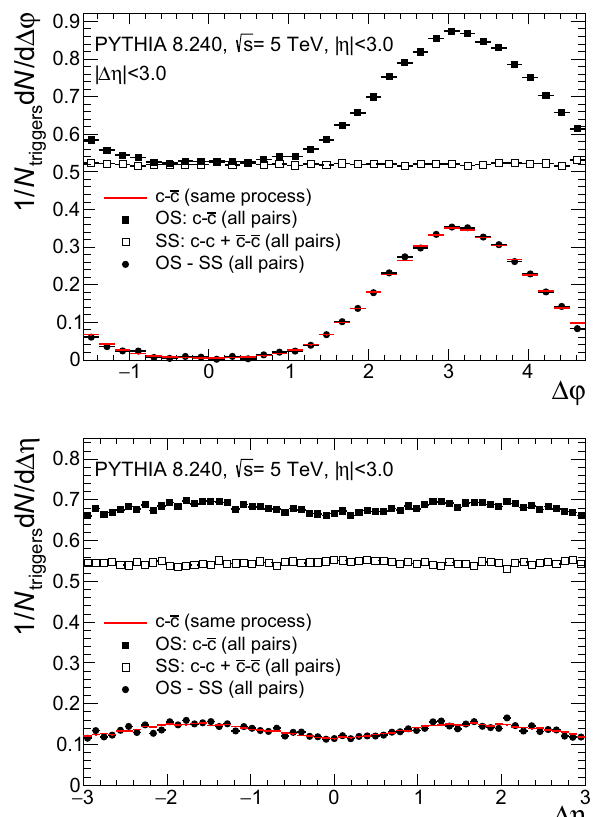
Fig. 3 Illustration of how one experimentally can extract the correla- tion between correlated charm and anticharm quarks produced in the same hard process (red line). The experimental observable (OS-SS) is constructed by subtracting the same sign (SS) per trigger yield from the opposite sign (OS) per trigger yield. Top: azimuthal correlations. Bottom: pseudorapidity correlations. Note that results are shown for all charm hadrons and that c and c only refers to the charm content of the